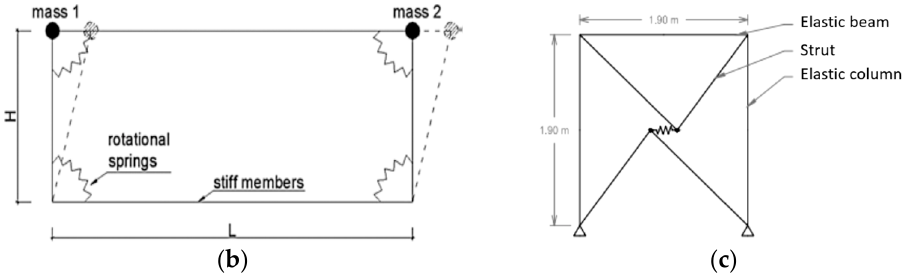
Figure 8. ( a ) In-plane test setup on a timber frame wall [47]. ( b ) A timber frame wall modeled using concentrated nonlinear springs. ( c ) An alternative approach for numerical modeling of the wall [46].